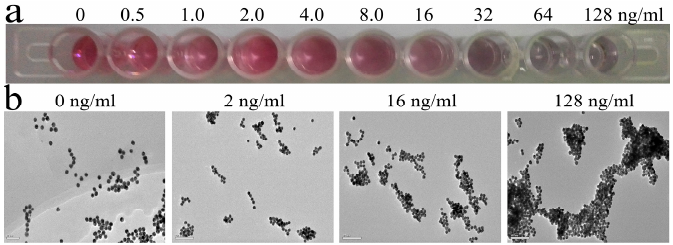
Figure 3. The characterization of AuNP-based aptamer-assay for detection of Hg 2+ . ( a ) Image of the assay colorimetric change with different concentrations of Hg 2+ ; ( b ) TEM images of AuNPs mixed with a 3 μ M aptamer and 3 M NaCl, in the presence of various concentrations of Hg 2+ .